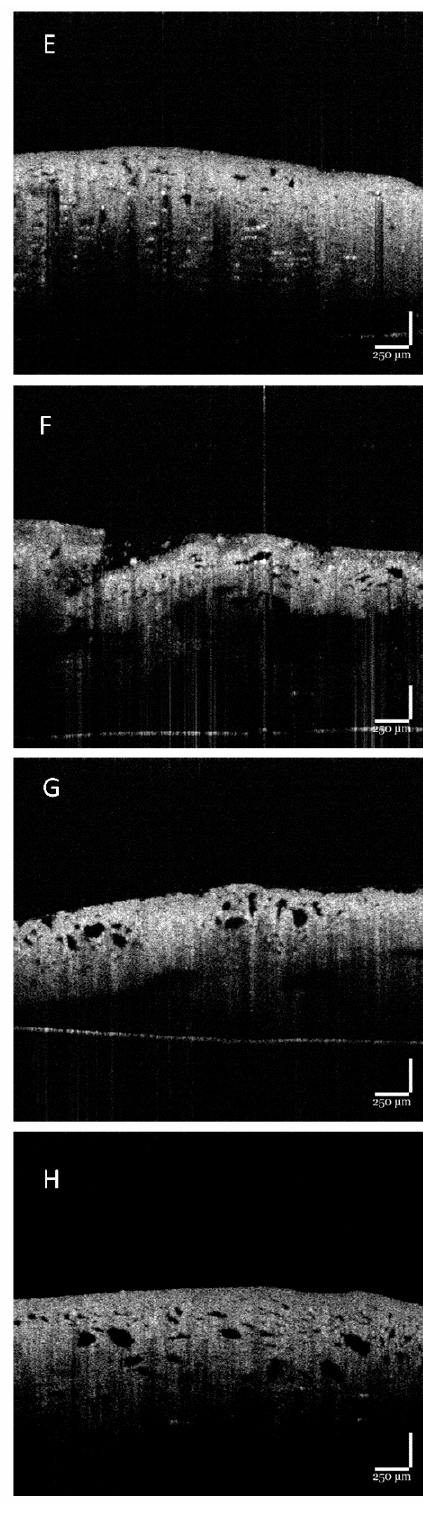
gained macro-pores.